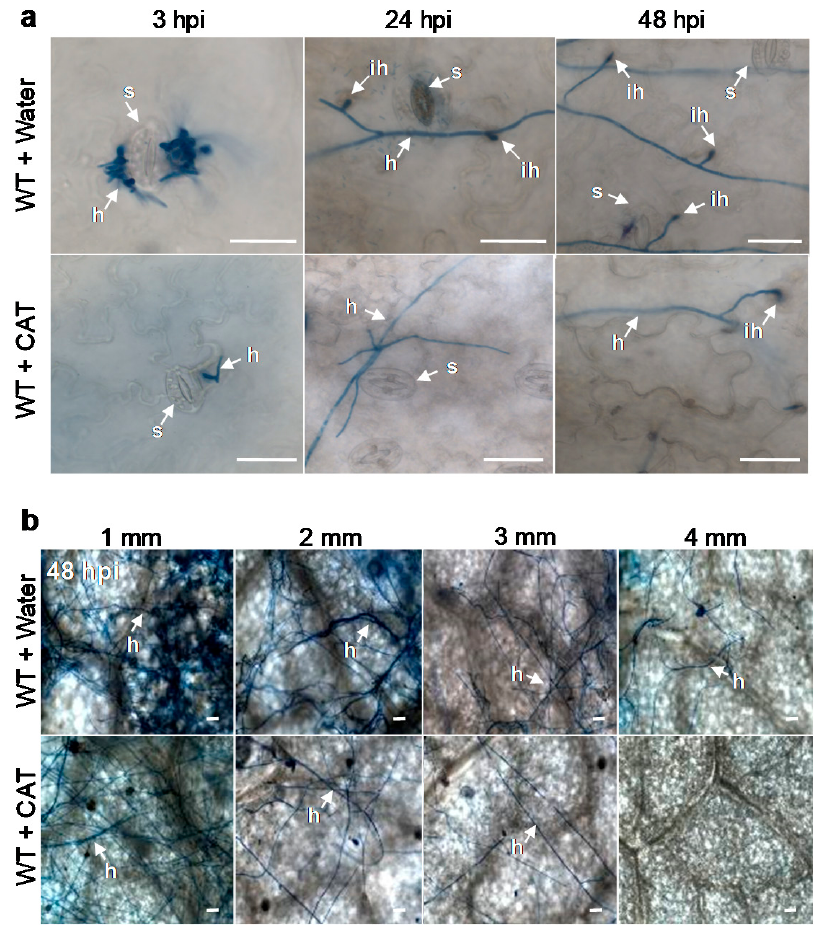
Figure 6. ROS scavenger catalase suppressed hyphal penetration and invasive hyphal growth of A. alternata . A. adenophora leaves pretreated with 300 U mL − 1 catalase or sterile water were inoculated with A. alternata wild-type mycelial homogenates (20 μ L) for the indicated times. ( a ) The effect of catalase on hyphal growth and penetration during the early-stage at 3, 24, and 48 h post inoculation (hpi). ( b ) The effect of catalase on invasive hyphal growth and extension on A. adenophora leaves inoculated by A. alternata at 48 h post inoculation (hpi). Tissues were stained with lactophenol-trypan blue to visualize hyphae. Here, s: Stomata; h: Hypha; ih: Invasive hypha; CAT: Catalase. Scale bars = 20 µ m. Experiments were repeated at least three times with similar results.